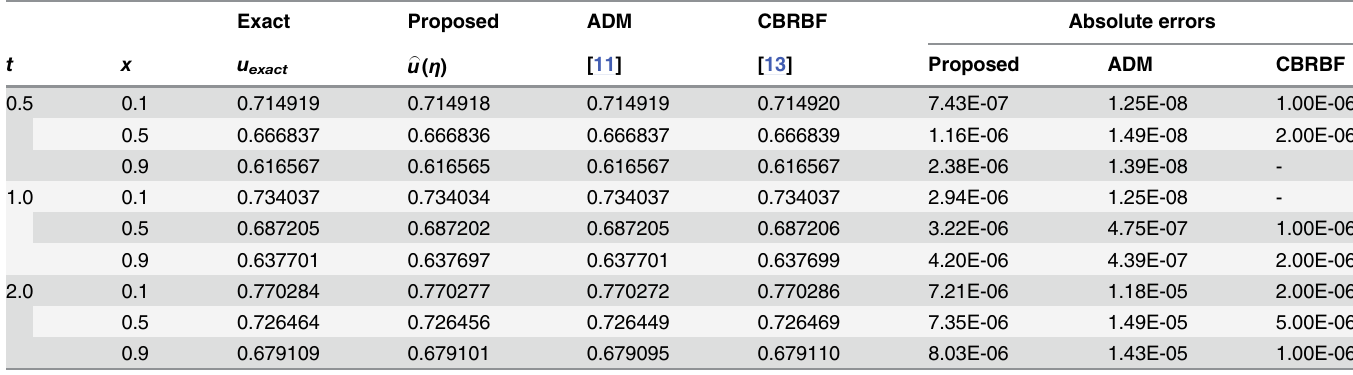
Table 11. Numerical solutions of generalized Burgers 0 equation by the proposed scheme and comparison with exact solutions, ADM [11], and CBRBF [13] for β = 0, α = 1, and δ =